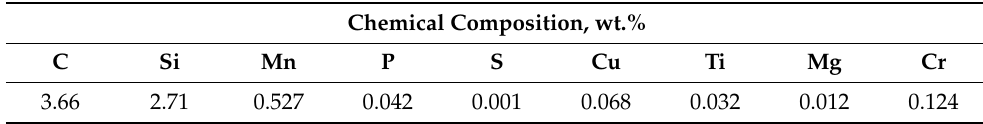
Table 1. The ductile cast iron EN-GJS-350-22 chemical composition. Chemical Composition,